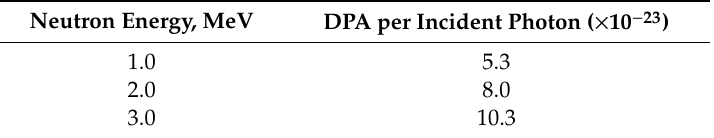
Table 5. Radiation damage due to neutron irradiation of the CLYC